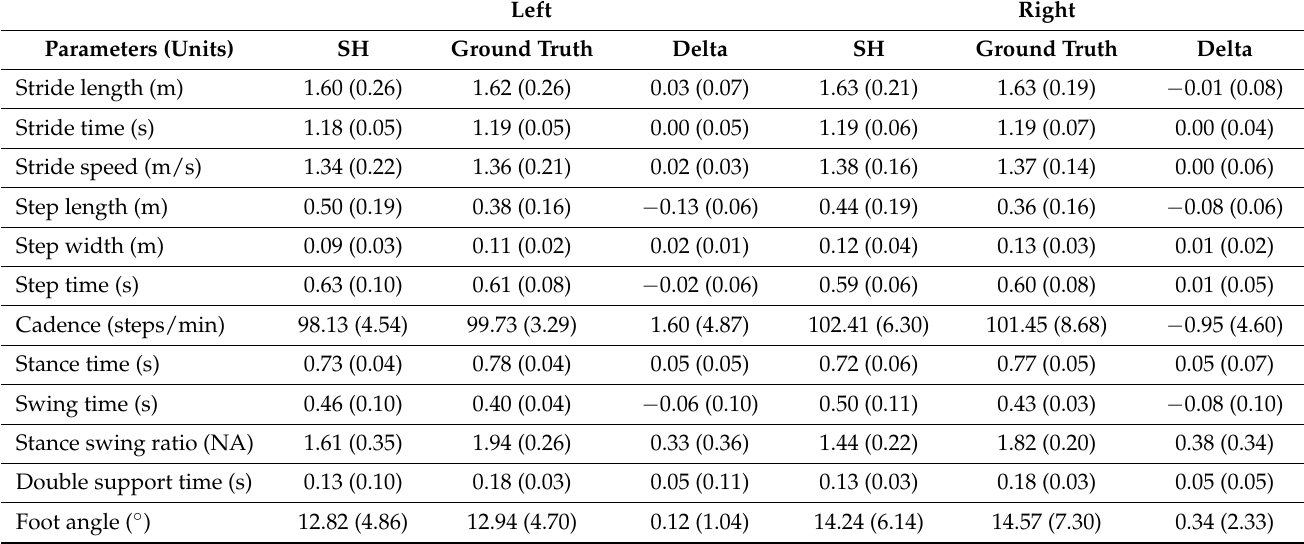
Table 7. Stride parameters for participant one from the Smart Hallway (SH) compared to ground-truth foot-event stride parameters for the walking-straight test (mean and standard deviation in